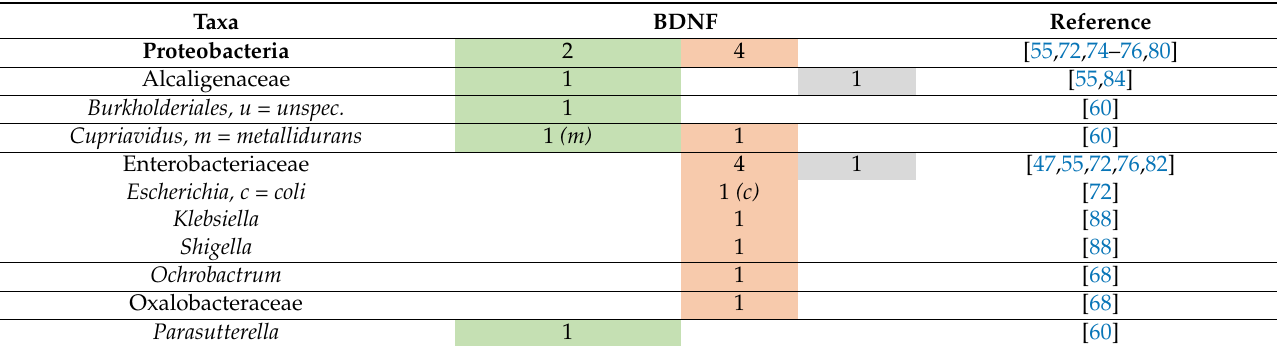
Table 8. Proteobacteria and